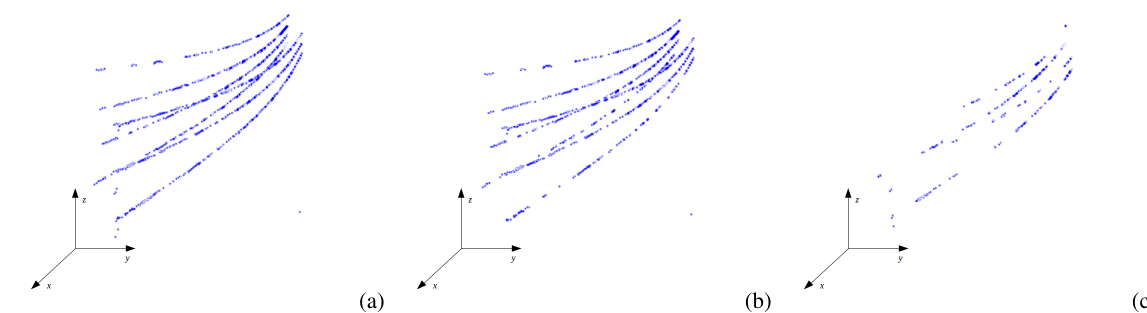
Figure 2. Results of each ICS iteration. (a) Fully merged iterations. (b) Results of the first iteration. (c) Results of the second iteration. Note that at the second iteration no points of the upper catenaries are detected, but only points of the mid and lower catenaries.